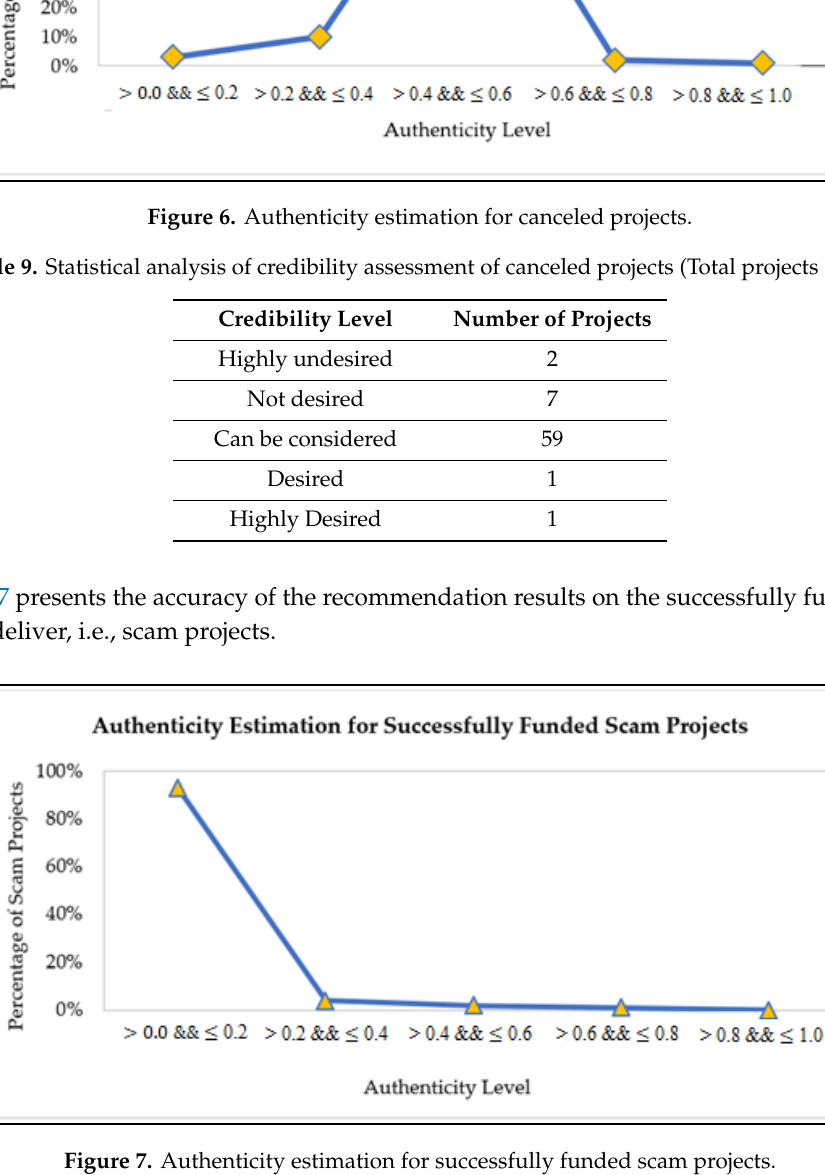
Table 10. Statistical analysis of credibility assessment of undelivered projects (Total projects = 120).